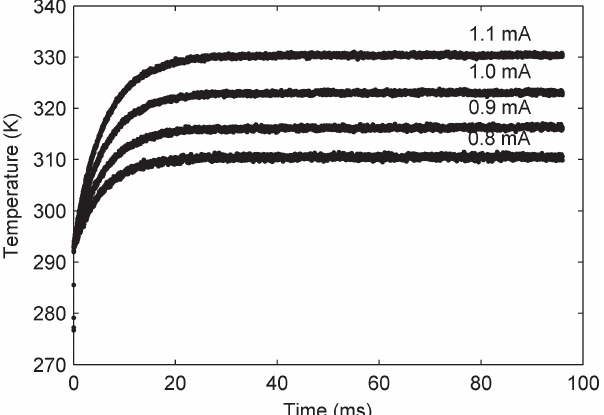
Figure 5. Temperature response curves of the emitter in the thermal time delay